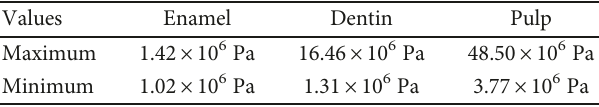
Table 4: 1st degree caries : von Mises stresses results.